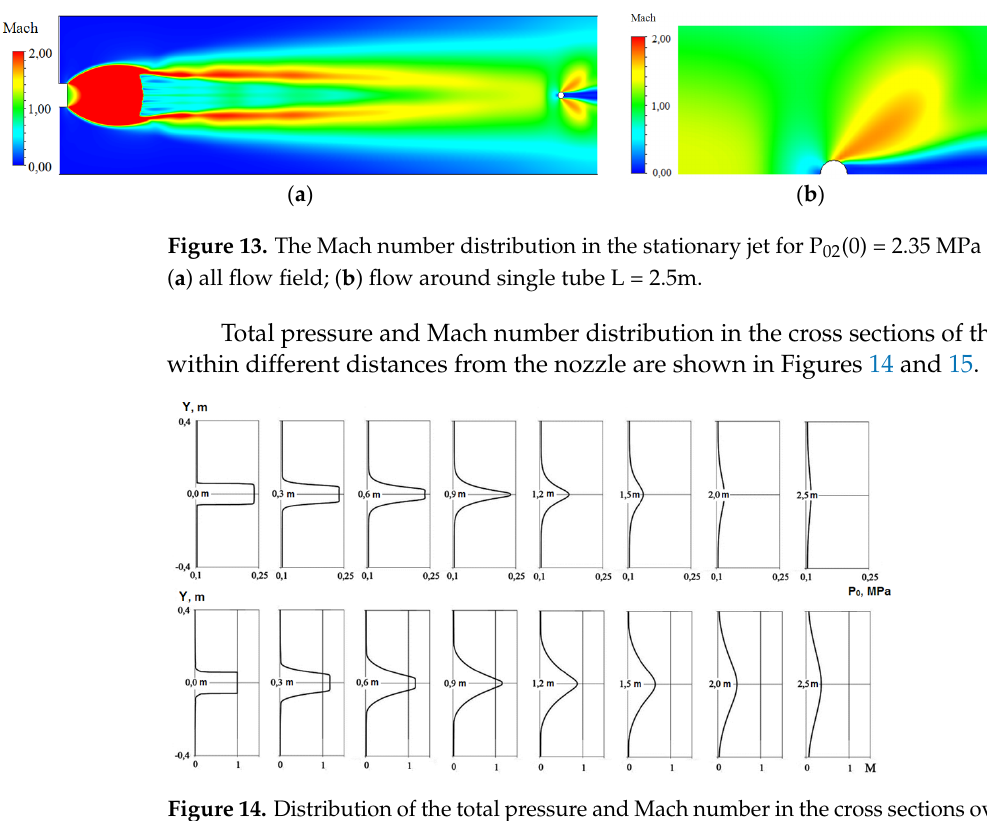
Figure 15. Distribution of the total pressure and Mach number in the cross sections over the station ‐ ary jet length for Р 02 (0) = 2.35 MPa at the nozzle cut. Figure 16 presents the mass ‐ average total pressure in the jet within different dis ‐ tances from the nozzle cut. As the initial pressure rises by 10 times ( Р 02 (0) = 2.35 MPa), the total pressure over the jet length reduces rapidly because of the shock waves, and at 2.5 m it exceeds the total pressure in the jet with the low initial pressure ( Р 02 (0) = 0.235 MPa) only by 1.5 times (see Figure 16b). ( a )